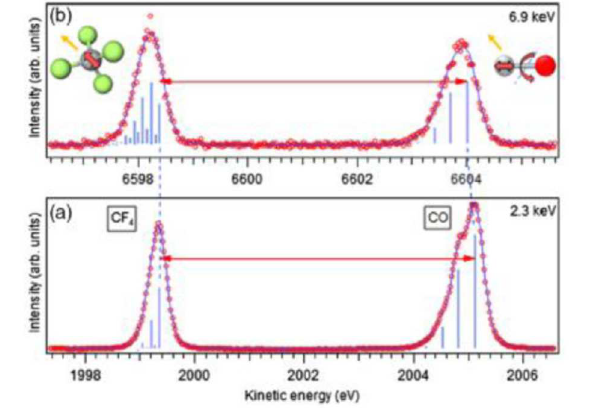
Fig. 4. C1s photoelectron of a mixture of